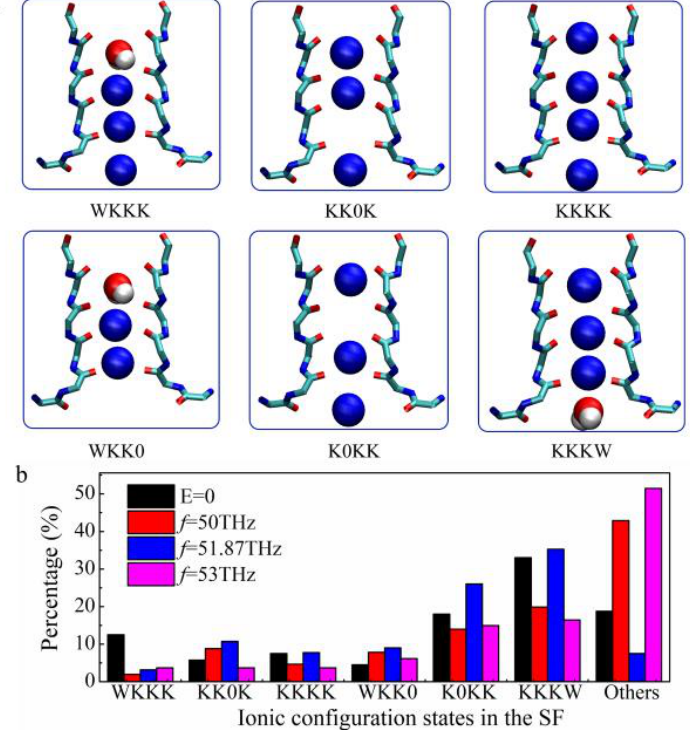
Figure 3. Percentage of ionic configuration states in the SF with and without the applied THz fields at different frequencies. ( a ) SF snapshots of all observed states by direct knock-on mechanism (the blue spheres are K + and the red sphere-white sphere assemblages are water molecules.). ( b ) The distribution of all observed states in direct knock-on mechanism (six states on the left) and soft knock-on mechanism (collectively named Others).